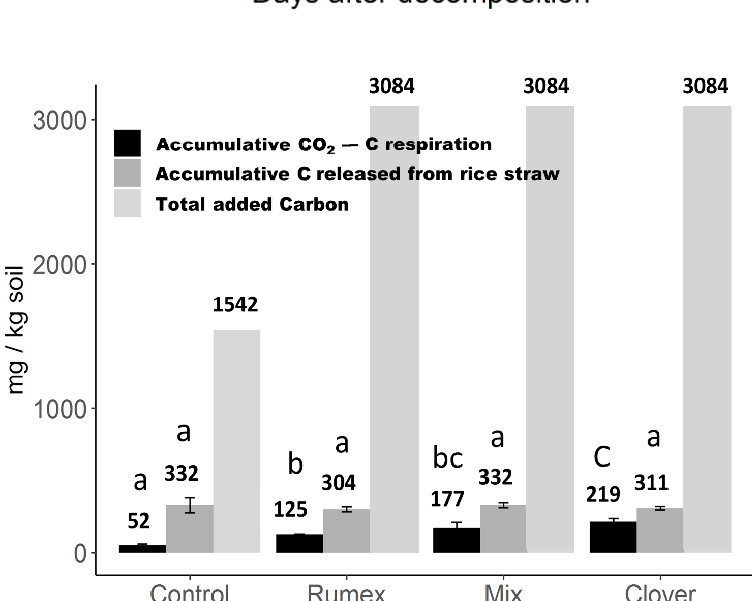
Fig. 1 Soil respiration at 7, 14, 21, and 28 days in the control, Rumex , mix, and clover treat- ments The level of significance was determined by two-way ANOVA. “Day:Treatment” shows the interaction between the day and treatment effects. ***, p < 0.001. Er- ror bars represent standard deviations of mean values (n = 3).